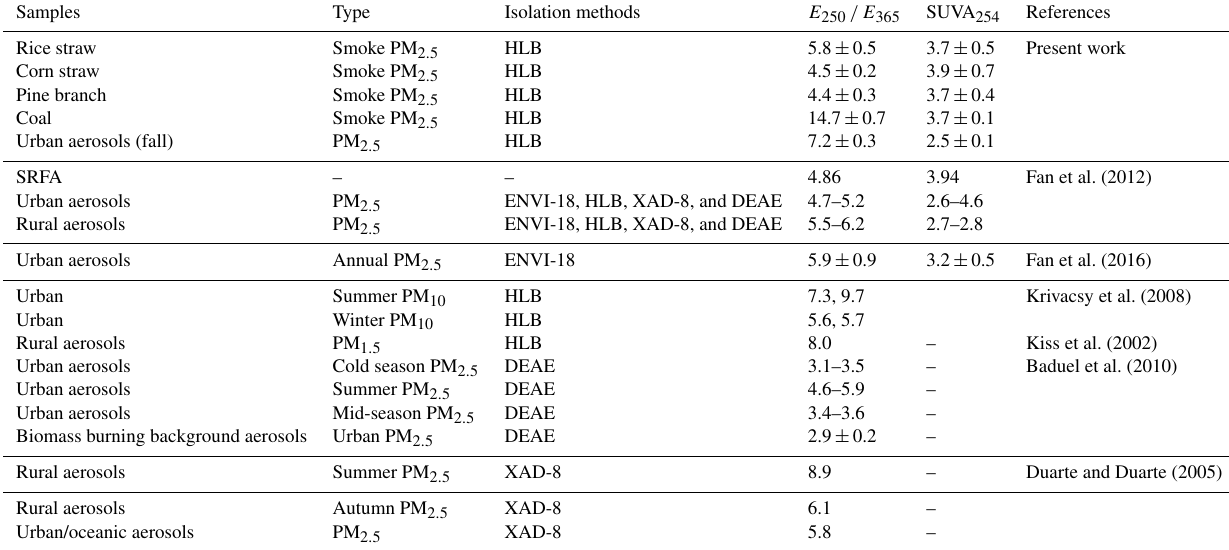
Table 4. Absorptivity ratio between 250 and 365nm ( E 250 /E 365 ) , and the specific UV absorbance at 254nm (SUVA 254 ) of HULIS in smoke PM 2 . 5 from combustion of rice straw, corn straw, pine branch, and coal, and in ambient PM 2 . 5